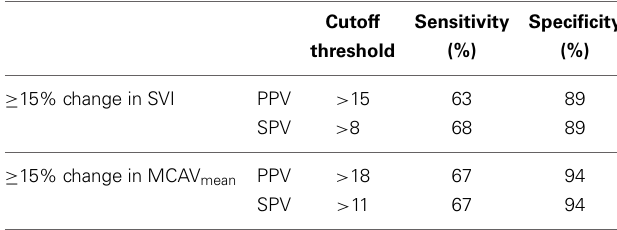
Table 2 | Predictive value of PPV and SPV for (changes in) SVI and MCAV mean with cutoff thresholds and corresponding sensitivity of